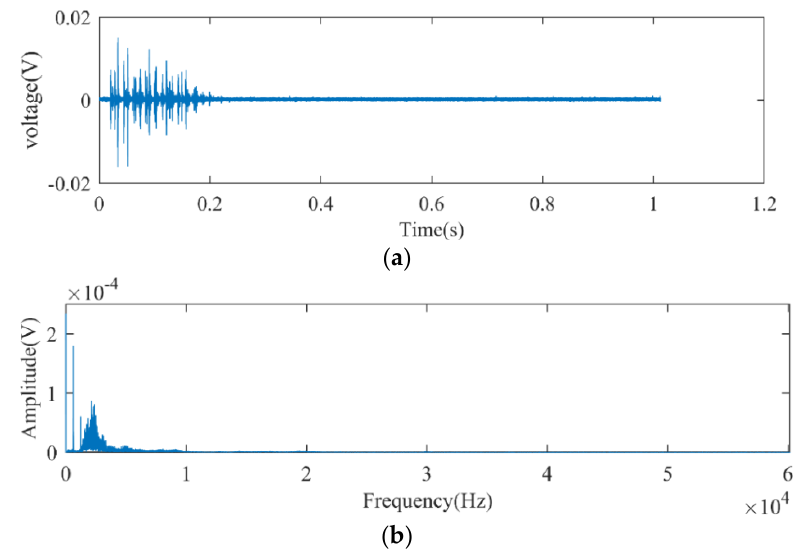
Figure 19. Time domain and frequency domain waveform diagram of noise signal of Yangma Island Bridge. ( a ) Signal time domain diagram; ( b ) signal frequency domain diagram.